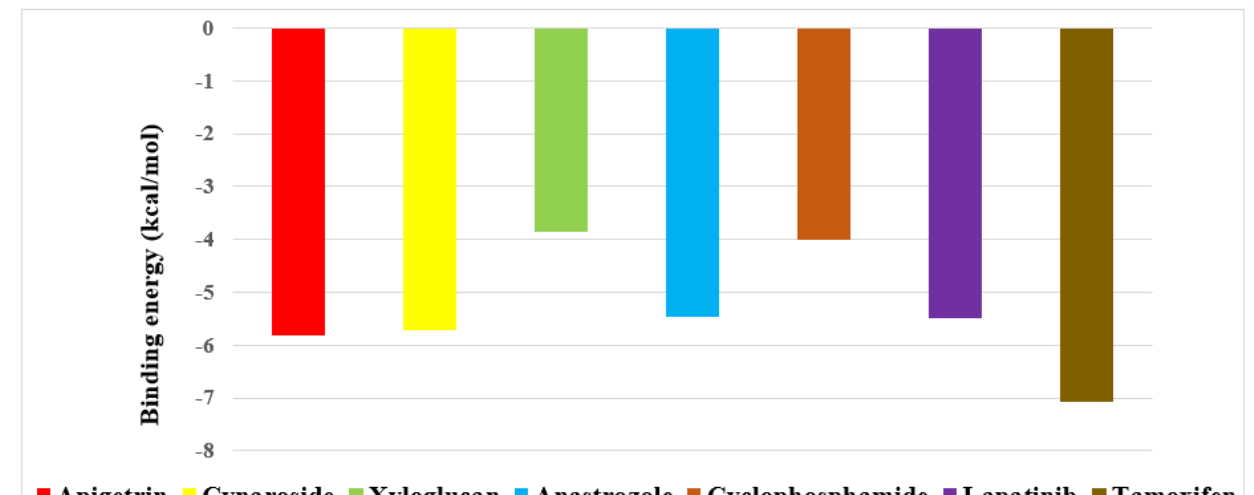
Figure 5. Graphical representation of the binding energy ( − kcal/mol) of the top three phytochemicals (apigetrin, cynaroside and xyloglucan) and standard drugs (anastrozole, cyclophosphamide, lapatinib and tamoxifen) in complexation with PR.